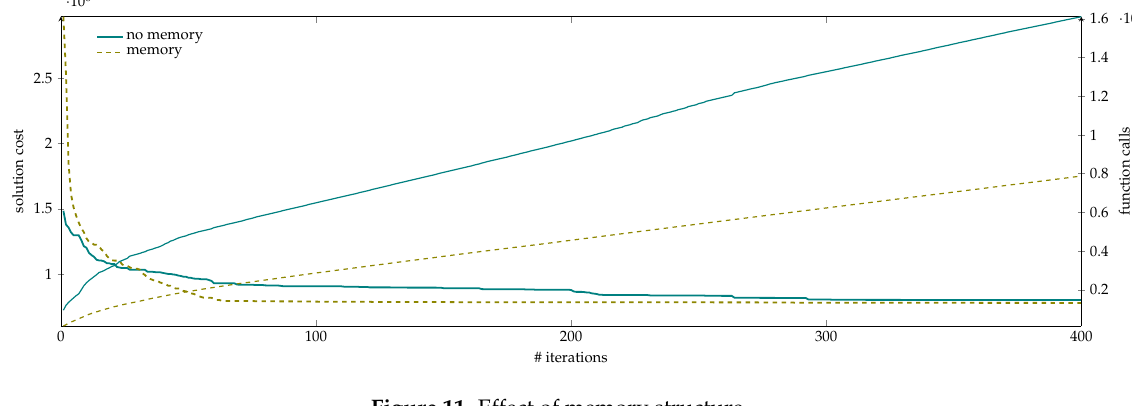
Figure 11. Effect of memory